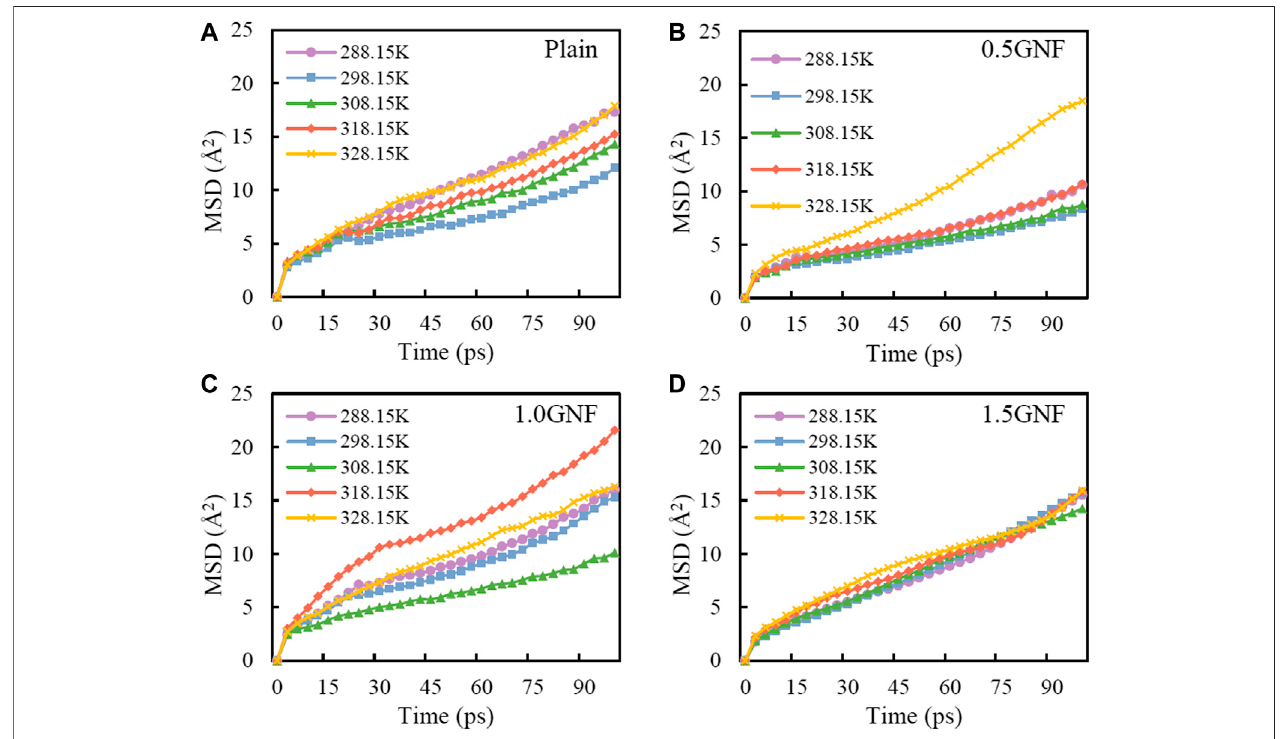
FIGURE 7 | Mean square displacement of the healing process of GNF modi fi ed PEN70 asphalt: (A) plain; (B) 0.5% GNF; (C) 1.0% GNF; (D) 1.5% GNF.